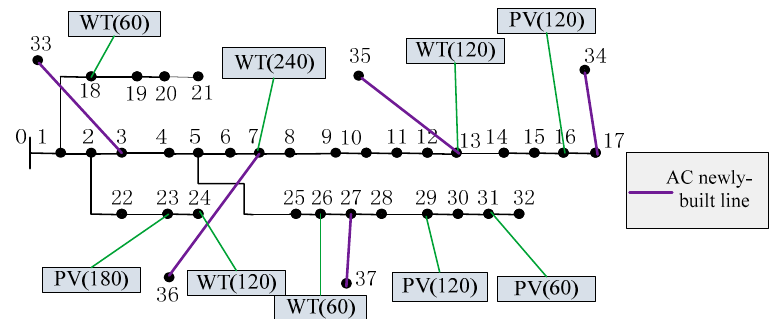
Figure 13. The structure of the AC DN after the planning.